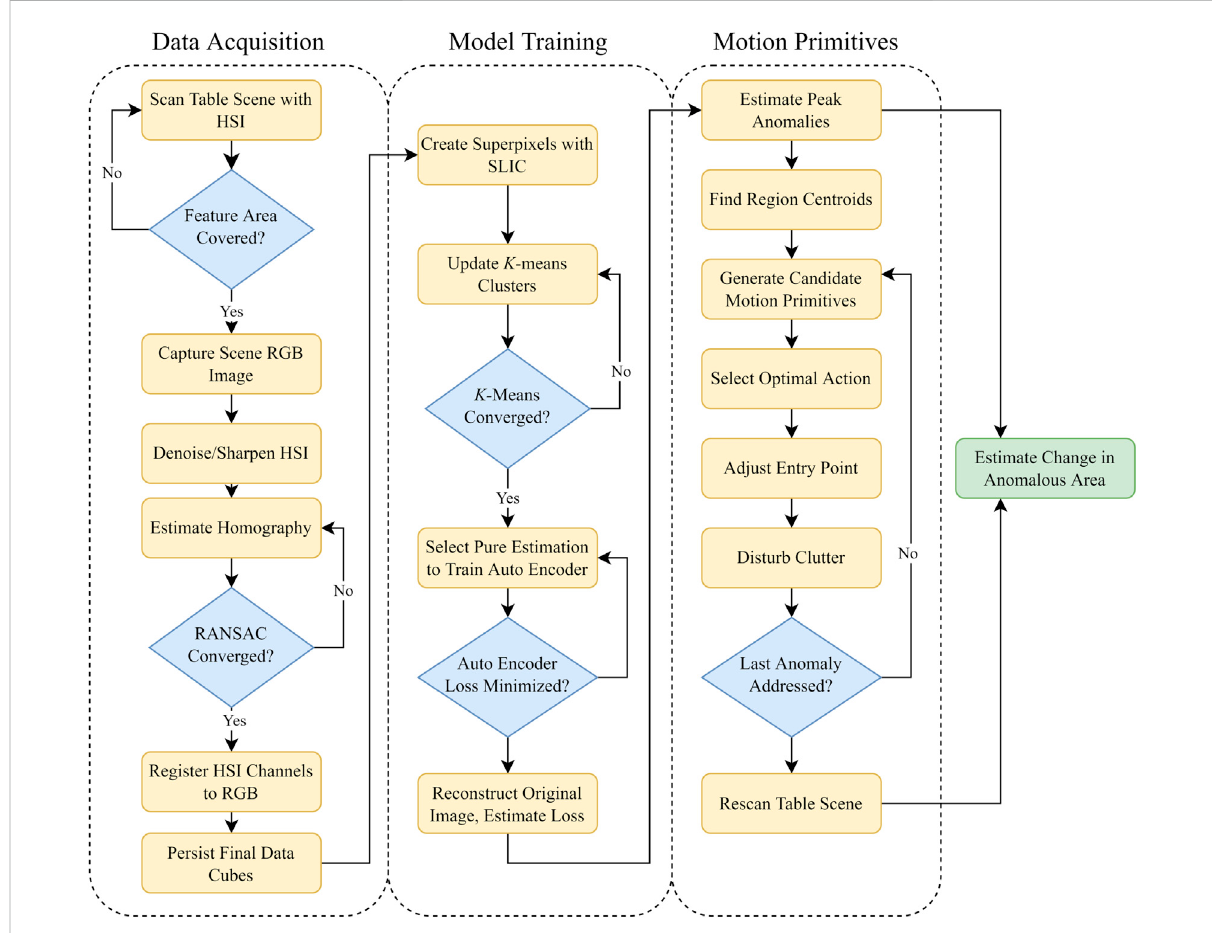
Frontiers in Robotics and